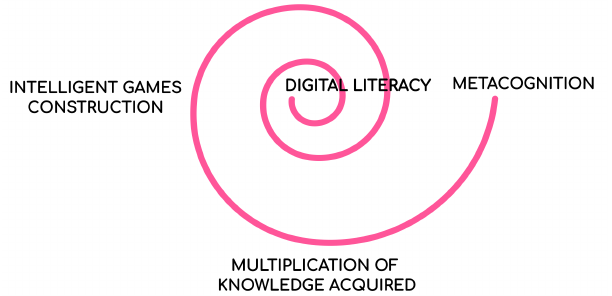
Figure 3 - Boehm representation work of